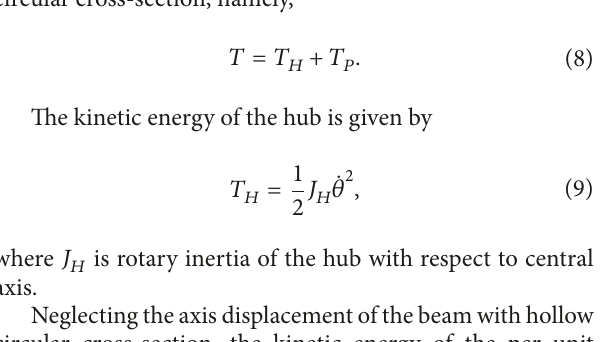
circular cross-section;